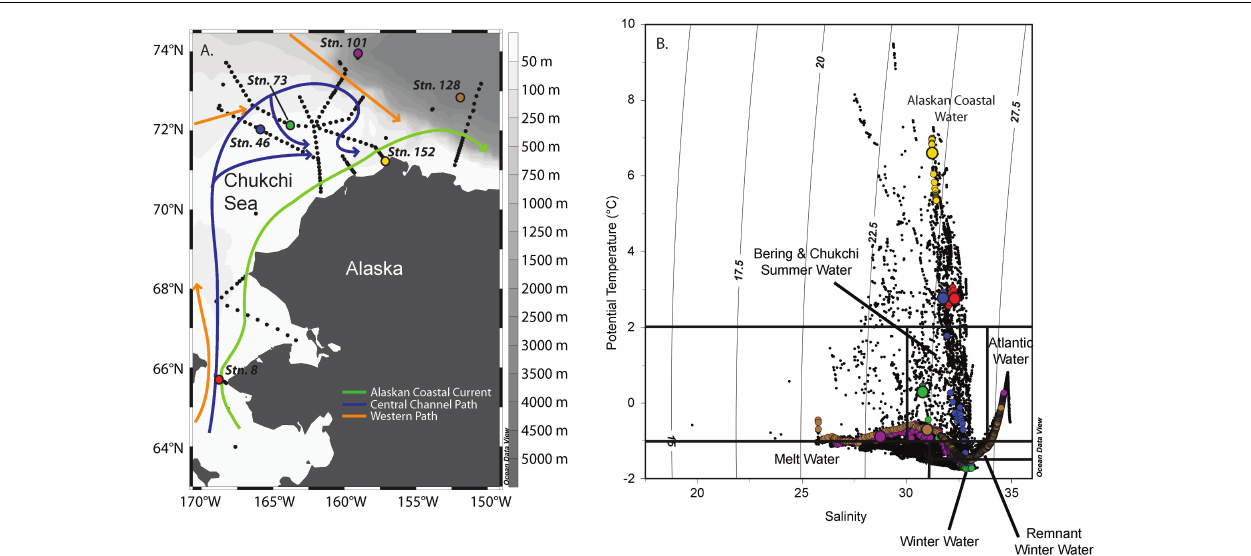
FIGURE 1 | Map of the Chukchi Sea showing the stations sampled during the ICESCAPE 2011 field campaign (A) . Stations where nutrient addition bioassays were carried out are shown as colored dots. Temperature (T) and salinity (S) relationship of waters sampled during ICESCAPE 2011. Vertical lines indicate water mass density (B) . The colored dots represent profiles at stations where nutrient addition bioassay were conducted, where colors match the stations in (A) . The largest dot in each profile is T-S of the sampled depth.